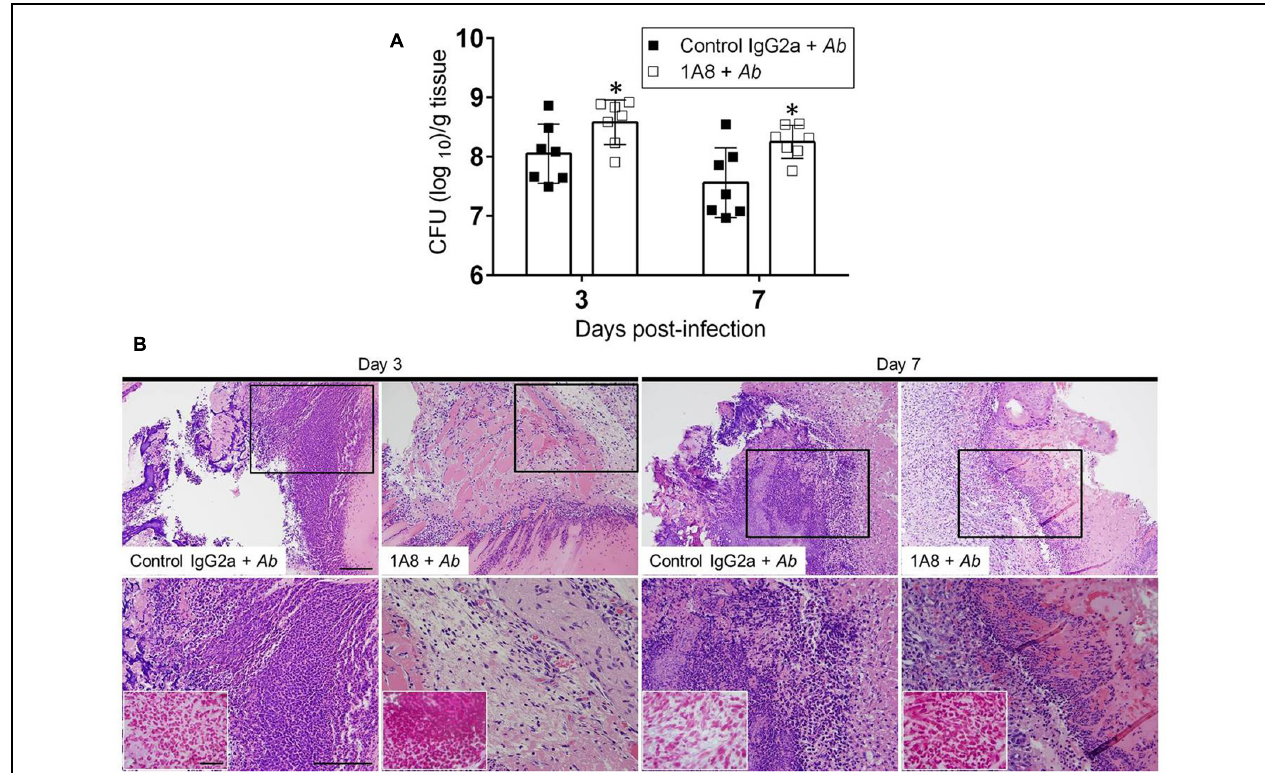
FIGURE 4 | Neutropenic mice show high bacterial burden in superficial skin lesions. (A) Wound bacterial burden (CFU; colony forming units) in control IgG2a and mAb 1A8-treated mice infected with 10 7 A. baumannii CFU. Three and seven days post-infection, infected skin tissue was removed from mice and bacterial burden determined. Bars are the averages of the results for seven clinical isolates (each symbol represent a strain; n = 7), and error bars denote standard deviations. Asterisks denote P -value significance ( ∗ P < 0.05) calculated by student’s t -test analysis. This experiment was performed twice with similar results obtained. (B) Histological analysis of Balb/c mice infected with A. baumannii 0057, days 3 and 7. Representative 20X (upper panel) and 40X (lower panel; magnified black boxes in upper panel) H&E-stained sections of the skin lesions are shown with the insets representing Gram staining for A. baumannii cells (shown in pink-red spots; lower panel). Scale bars: 20 μ